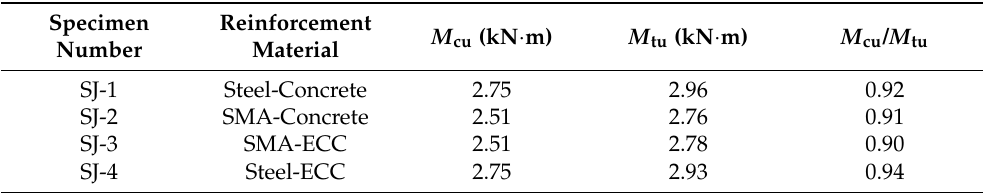
Table 6. The theoretical values and the experimental values of bending capacity for the strengthened